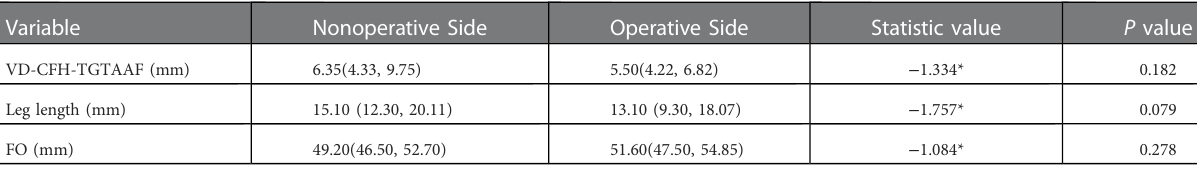
TABLE 3 Comparison of VD-CFH-TGTAAF, leg length, and FO of the operative side and the nonoperative side in IM-CMFH group. Variable